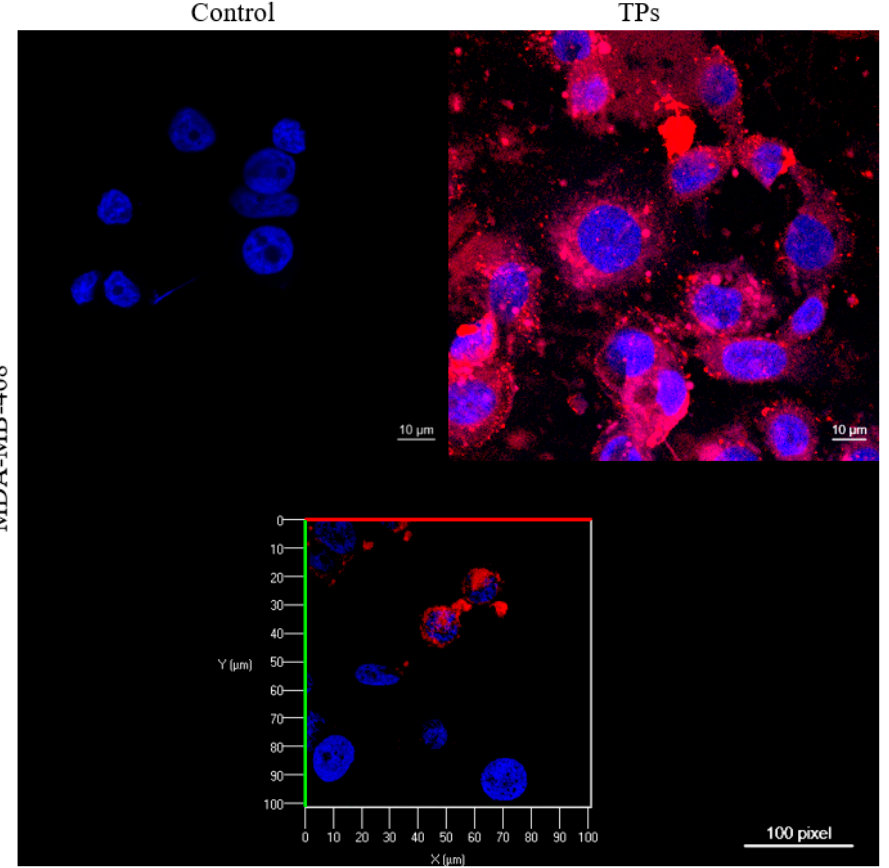
Figure 6. Micrograph of the MDA-MB-468 cell line for the analysis of the internalization of TPs. Blue staining reveals the fluorescence of DNA-bound DAPI in the cell nucleus and red staining refers to the fluorescence of TPs in the cell cytoplasm.